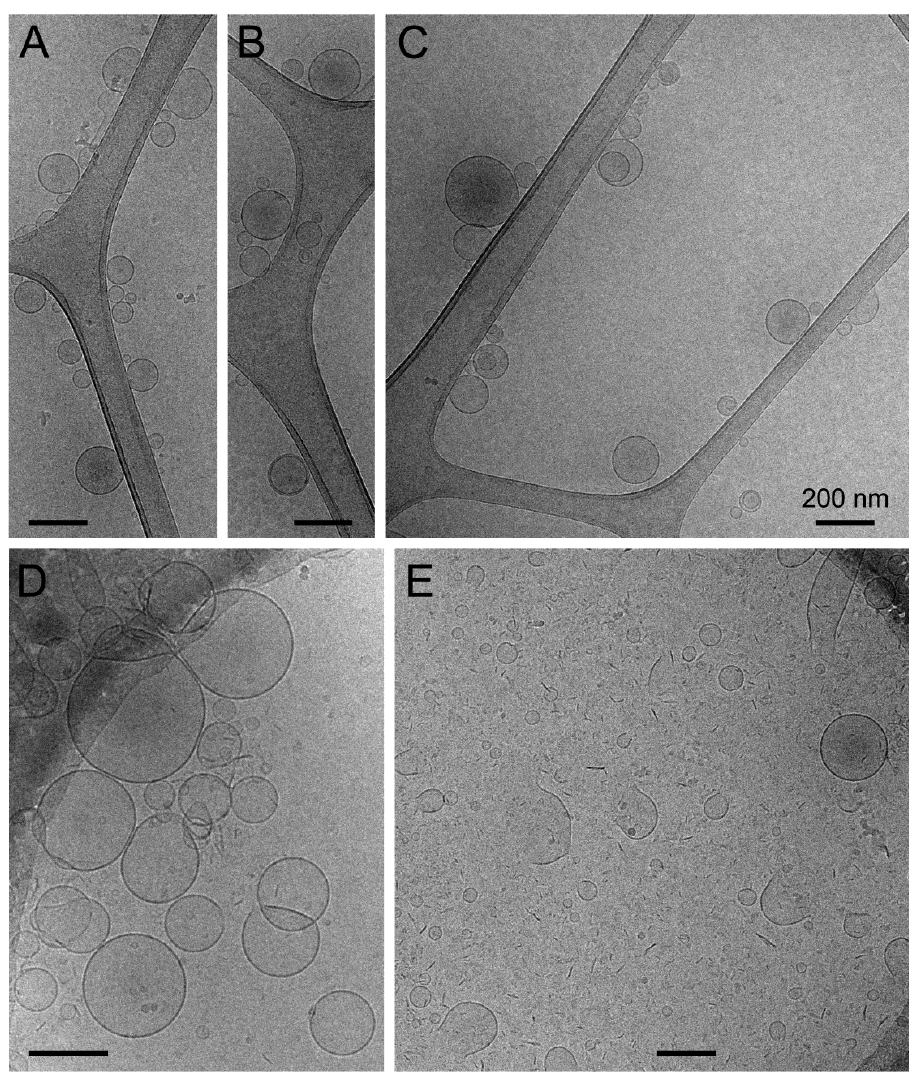
Figure 2. Cryo-TEM analysis of rehydrated curcumin-incorporating ( A – C ) Eudragit-nutriosomes and ( D , E ) Eudragit-hyaluronan liposomes. Scale bars represent 200 nm.